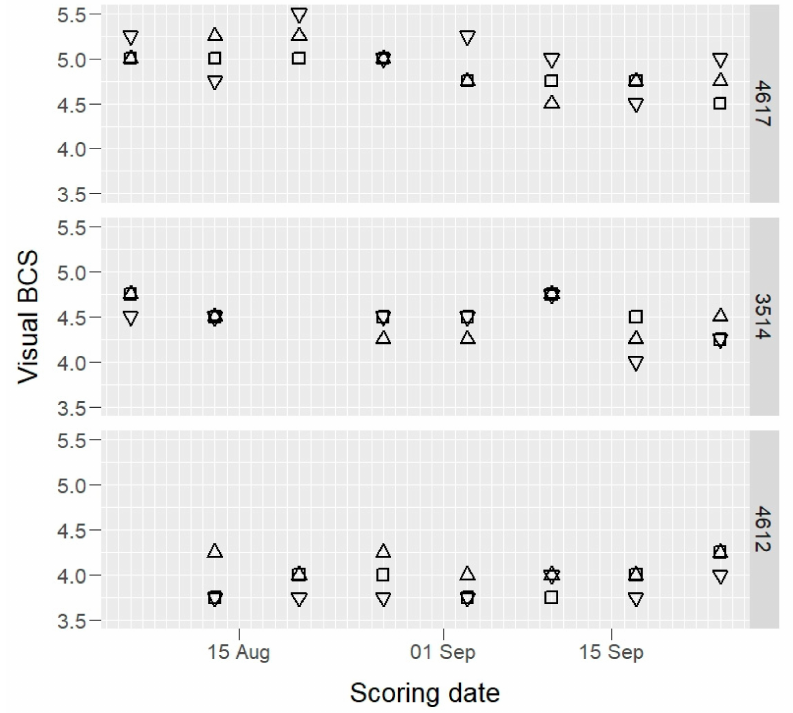
Figure 2. Visual body condition score (BCS) values of three selected cows (4617, 3514, and 4612: maximum, median, and minimum BCS mean value cows) by three scorers (open squares, open triangles, and inverted open triangles) on 1–8